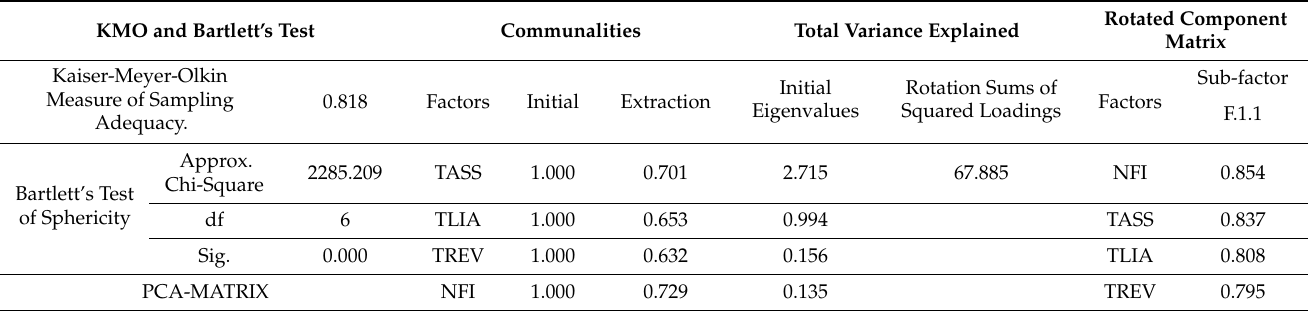
Table 5. Results of the first sub-factor (F1.1) of sustainable profit through factor analysis.